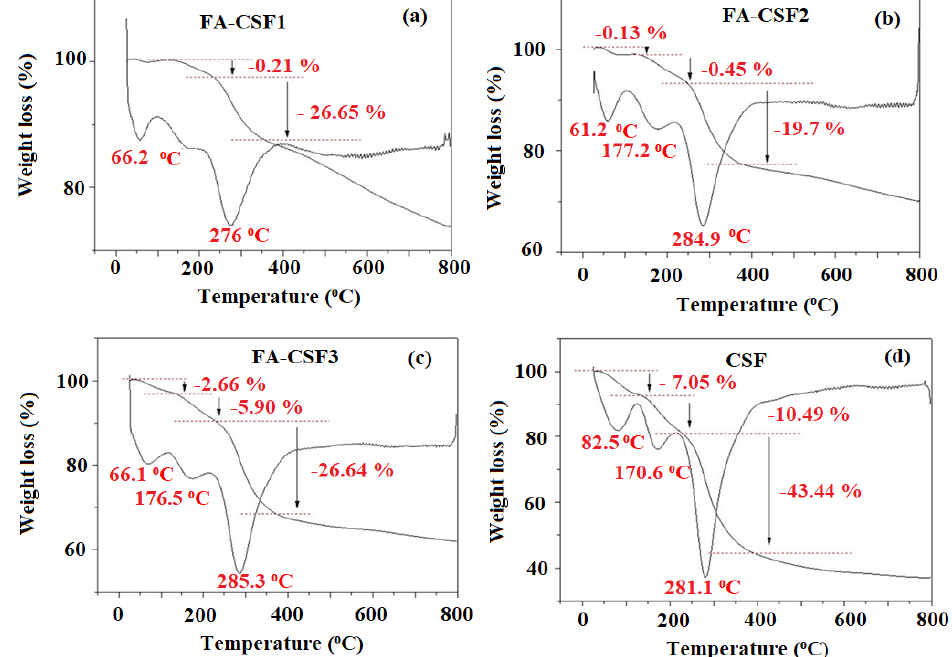
Figure 4. Thermogravimetric analysis showing the effect of fly ash concentration on the thermal stability of chitosan membrane, where ( a ) FA-CSF1, ( b ) FA-CSF2, ( c ) FA-CSF3, and ( d ) CSF.